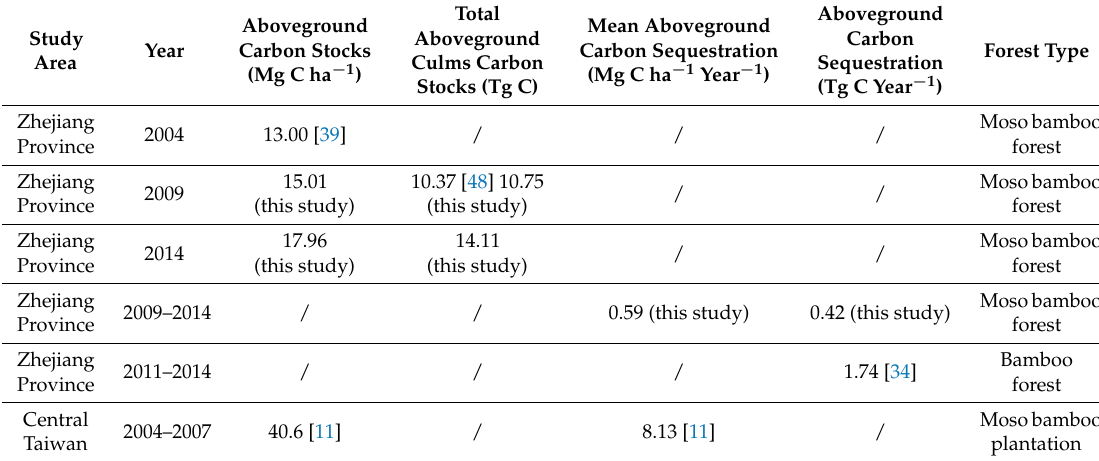
Table 2. A comparison of aboveground carbon stocks, mean aboveground carbon sequestration, and aboveground carbon sequestration between this study and other